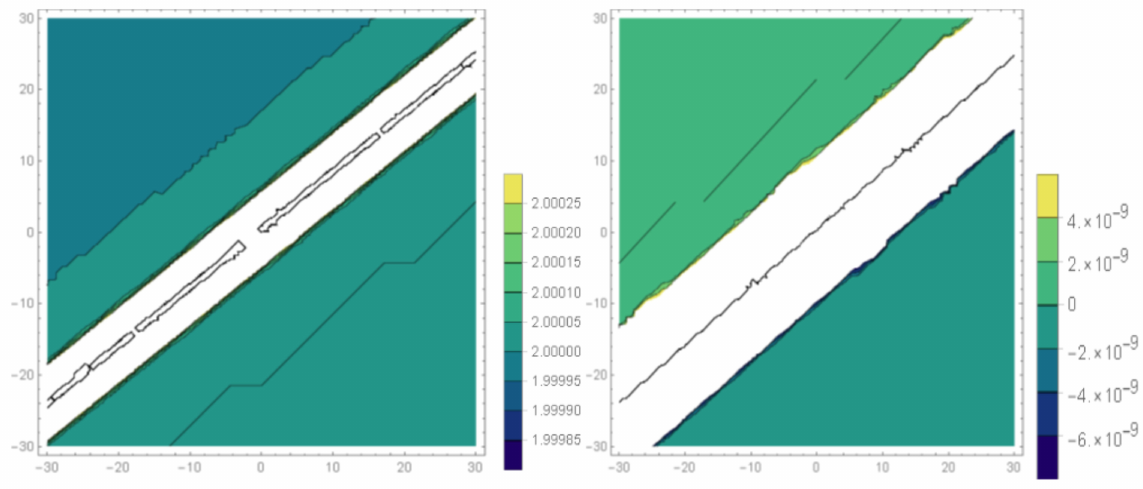
Figure 15. The contour graphs of Equation (26) under the values of ε = 0.4, − 30 < x < 30, − 30 < t < 30.